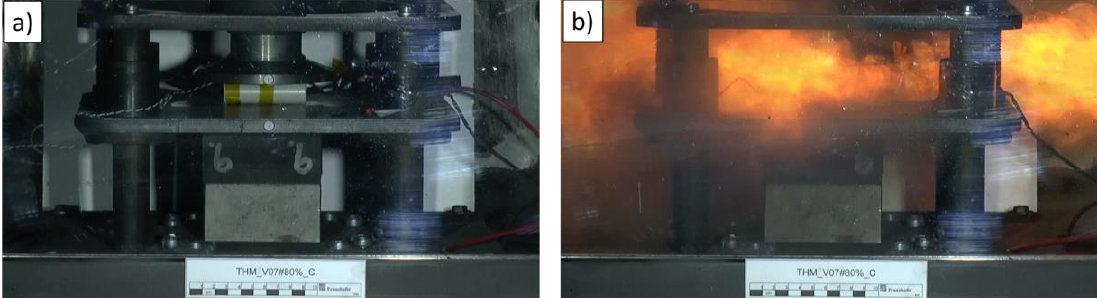
Figure 8. Experiment: Flat compression with v = 10 mms −1 of cell with SoC of 80%. ( a ) first contact between flat impactor and batteries. ( b ) maximum shows maximum intrusion and the fire burst.